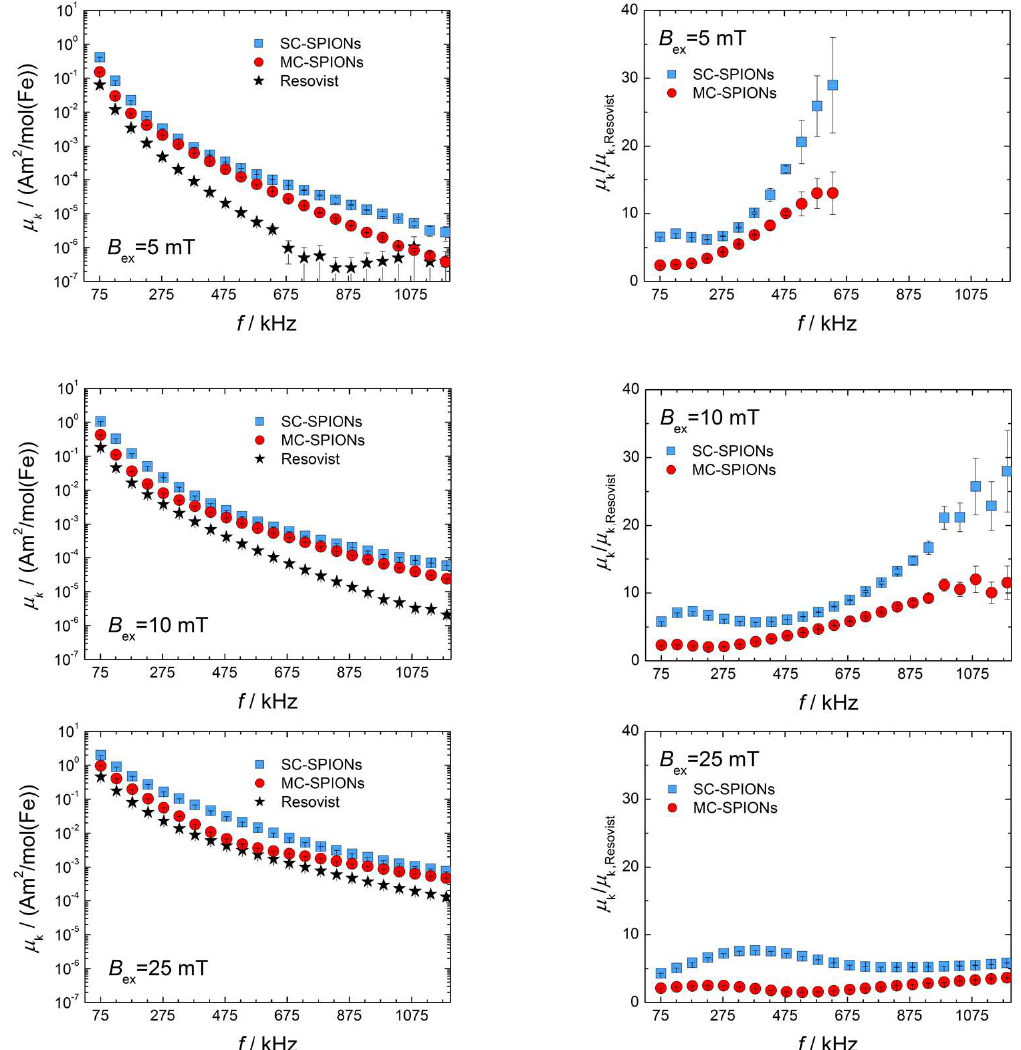
Figure 6. Magnetic particle spectroscopy (MPS) experimental data (odd harmonics only) of SC-SPIONs, MC-SPIONs and Resovist plotted as magnetic moment µ k versus frequency f ( left column ); and magnetic moment ratios of SC-SPIONs and MC-SPIONs versus Resovist defined as µ k /µ k , Resovist ( right column ) at an excitation field B ex of 5 mT, 10 mT, and 25 mT. Data points are shown up to a relative uncertainty of 50%.